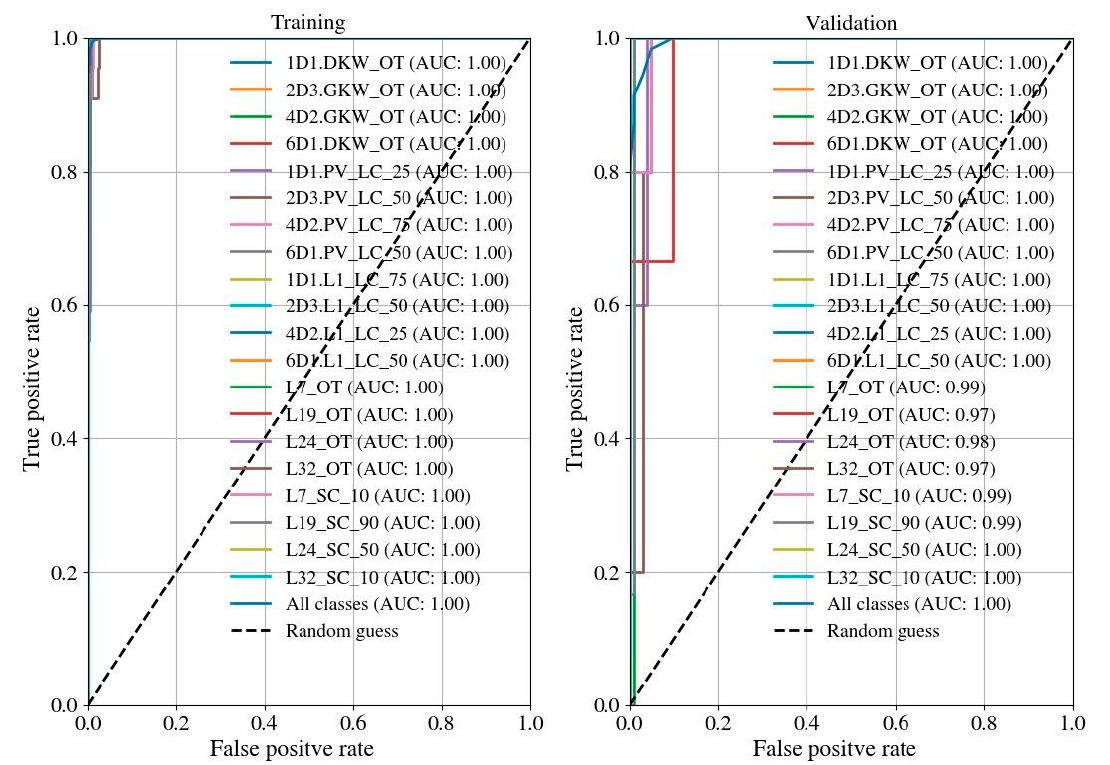
Figure 21. Receiver operating characteristics for training ( left ) and validation ( right )